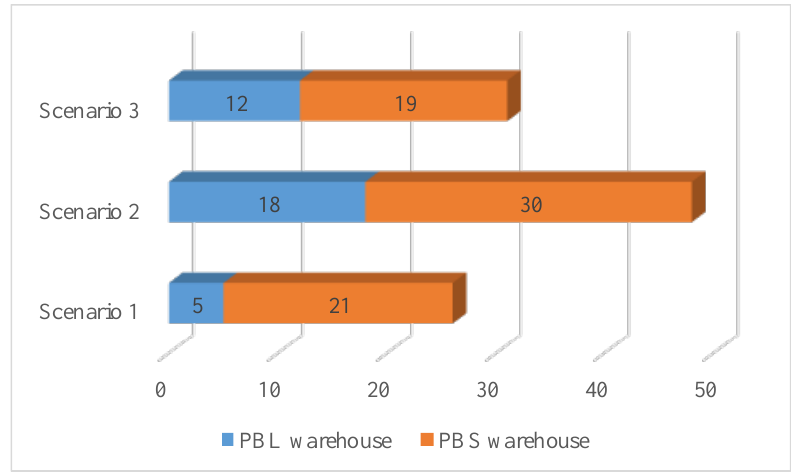
Figure 4. General results of the cost